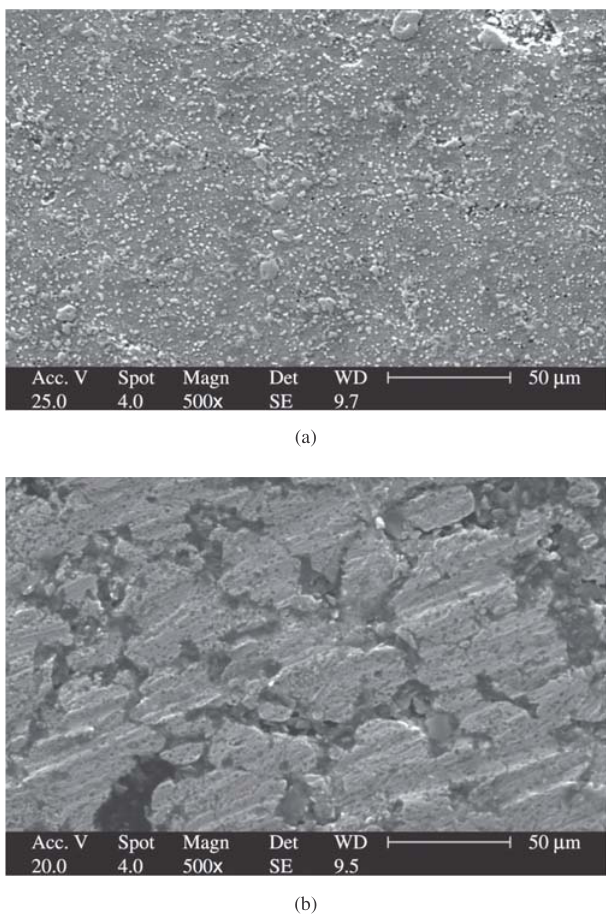
Figure 2. Scanning electron micrographs of electrode 1: a) before; b) after potentiostatic